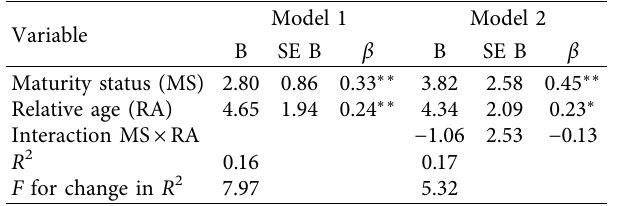
Table 4: Summary of hierarchical regression analysis for variables predicting 20m (s) sprint time.